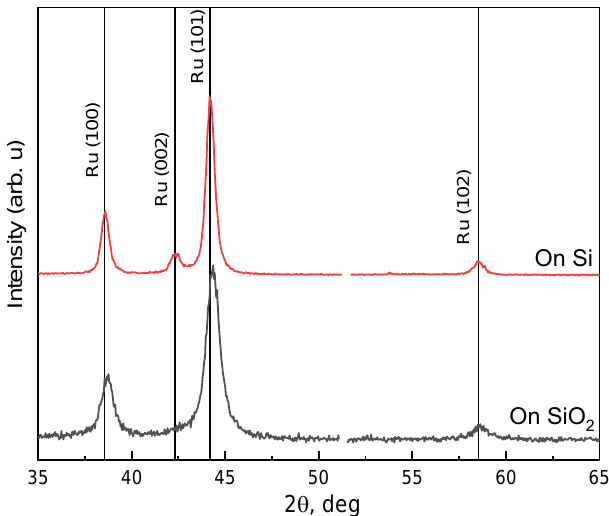
Figure 3. GXRD pattern of as grown Ru deposited at substrate temperature 400 °C on Silicon and SiO 2 (850 nm)/Si substrates.